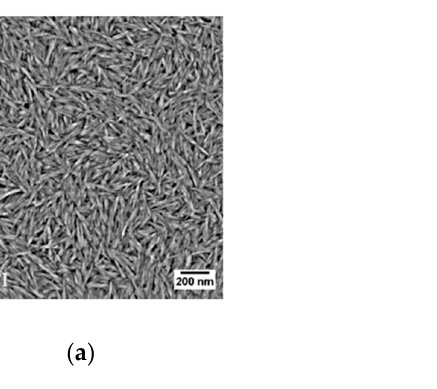
Table 3. Charge density and properties of the nanocellulose qualities.